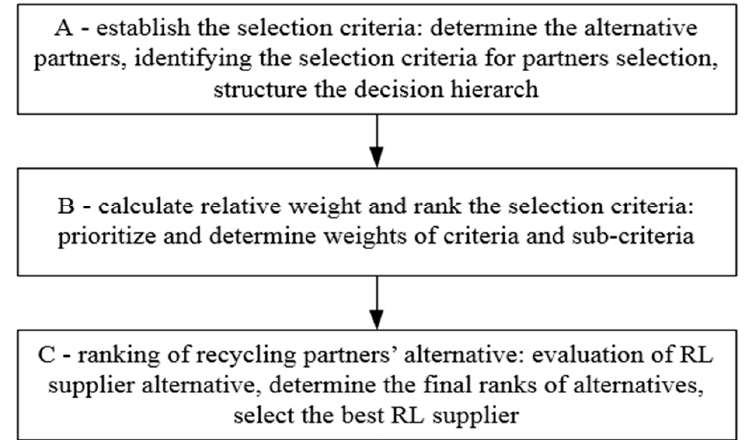
Figure 1. RL supplier selection process.